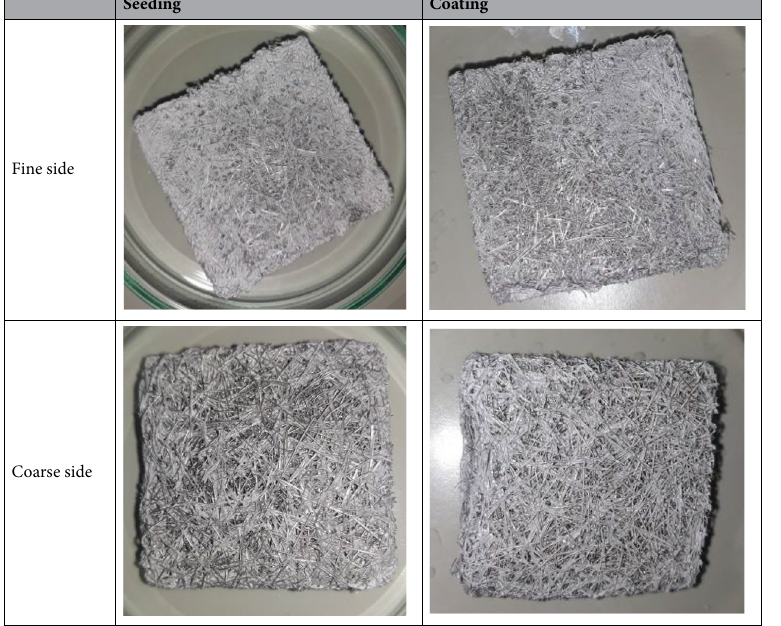
Table 2. MgSO 4 seeding and coating on aluminium fibre